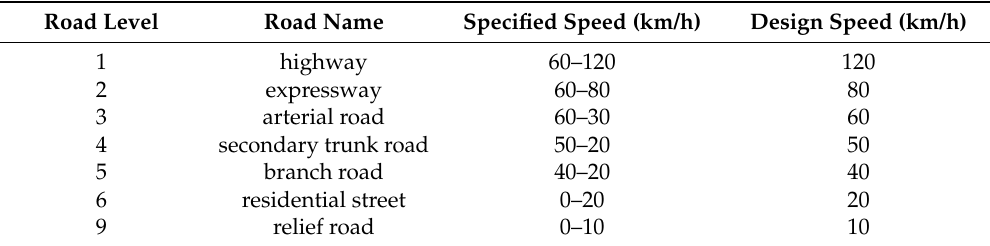
Table 3. Design of vehicle speed on urban roads in